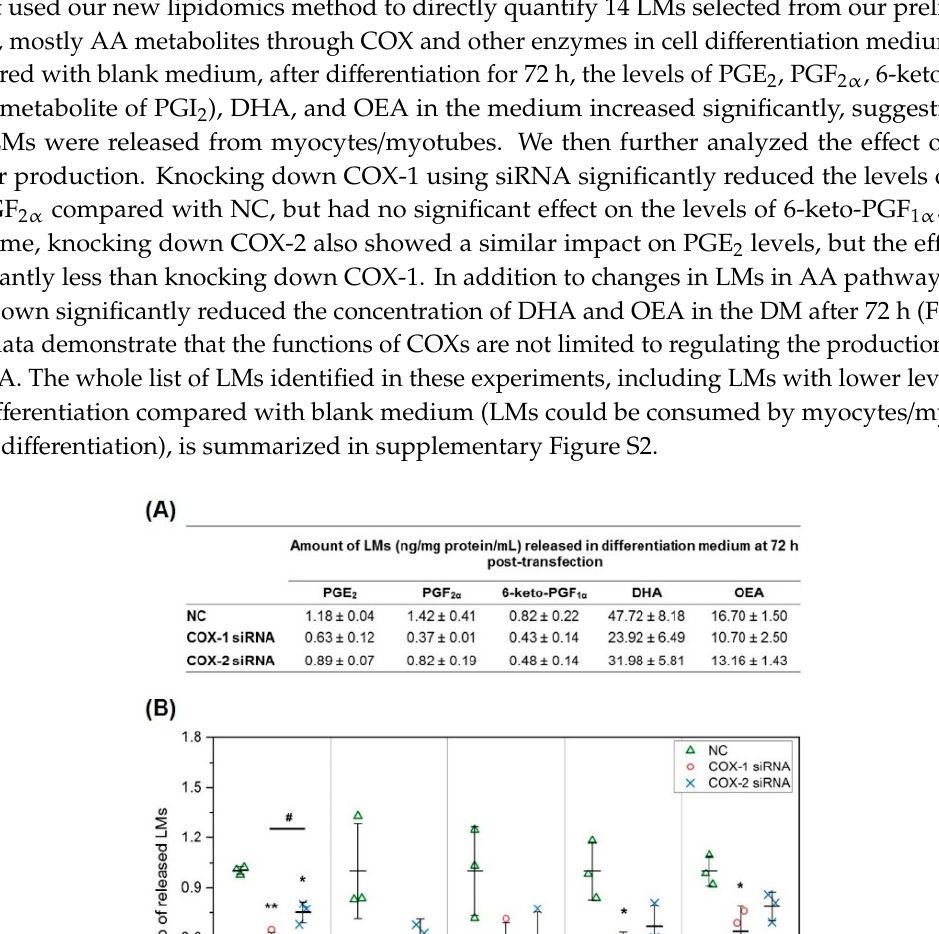
Figure 3. Knockdown of COXs reduces the levels of hydroxyeicosatetraenoic acids (HETEs) released by primary muscle cells. The levels of 12-HETE and 15-HETE, but not 5-HETE are significantly